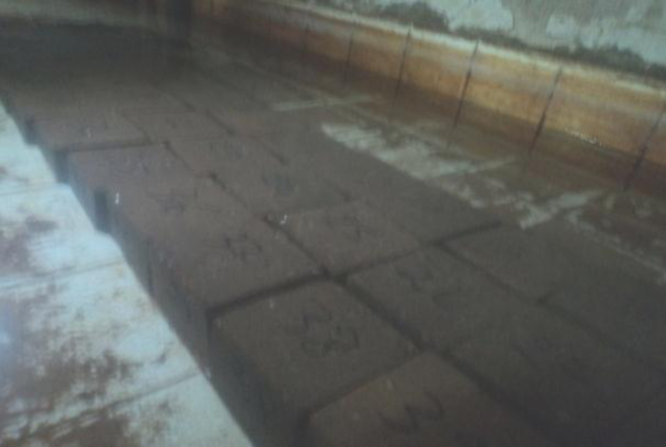
Immersion of blocks.